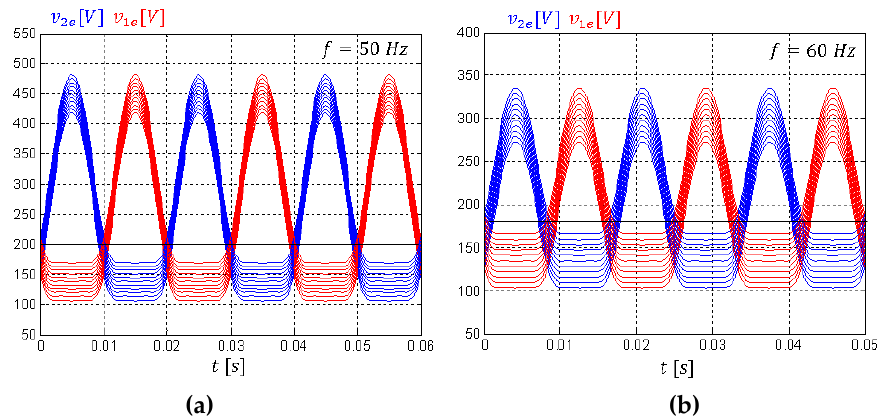
Figure 8. Evaluation of three cycles of the waveforms of the capacitor voltages for the entire range of input voltage at full load. ( a ) Standard 220 V @ 50 Hz and ( b ) standard 120 V @ 60 Hz.